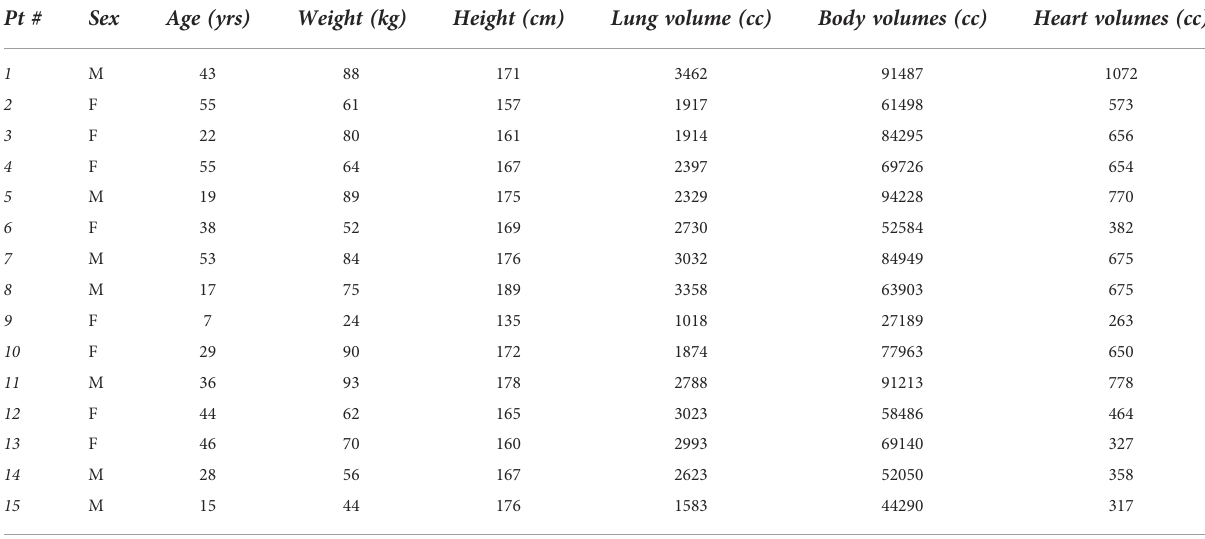
TABLE 1 Patient